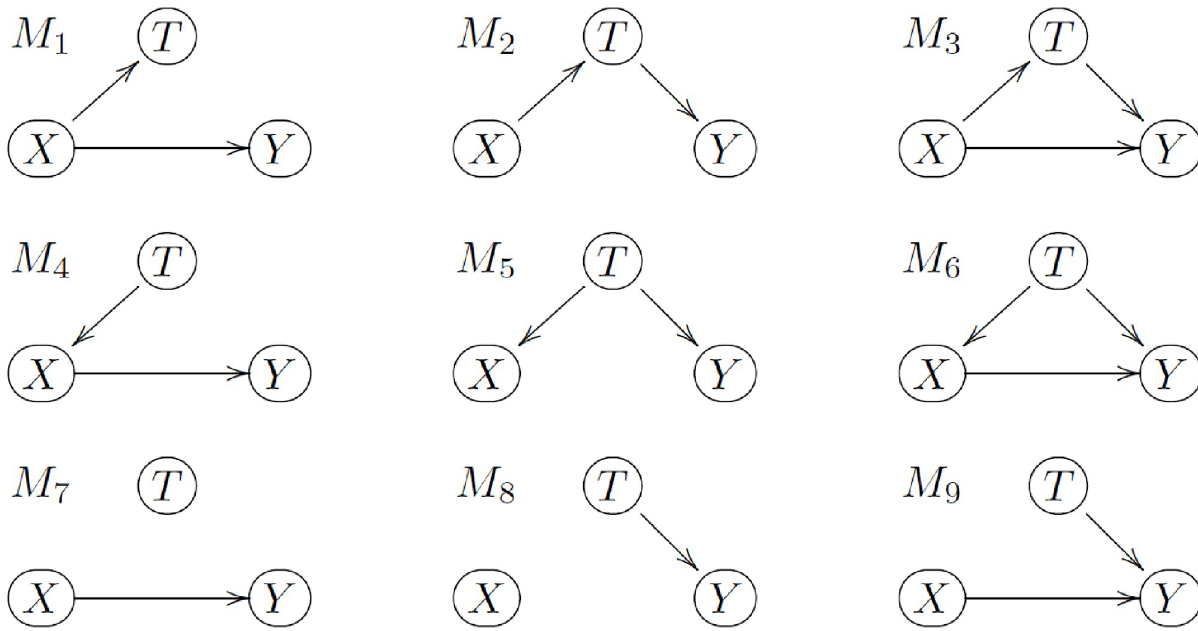
Fig 2. Putative causal models involving the X , T , and Y variables. No causal links from Y to X or T are not allowed.